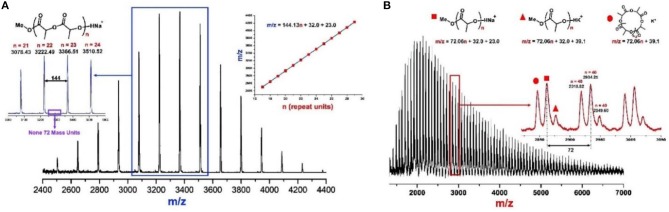
MALDI-TOF mass spectra of PLAs produced by (A) urea 1/KOMe = 3/1, [M]0/[I]0 = 50, −60°C, 1 min, 85% conversion, Mn = 4.0 kDa, Ð = 1.08; and (B) KOMe, [M]0/[I]0 = 50, 20°C, 20 min, 70% conversion, Mn = 3.2 kDa, Ð = 1.45.